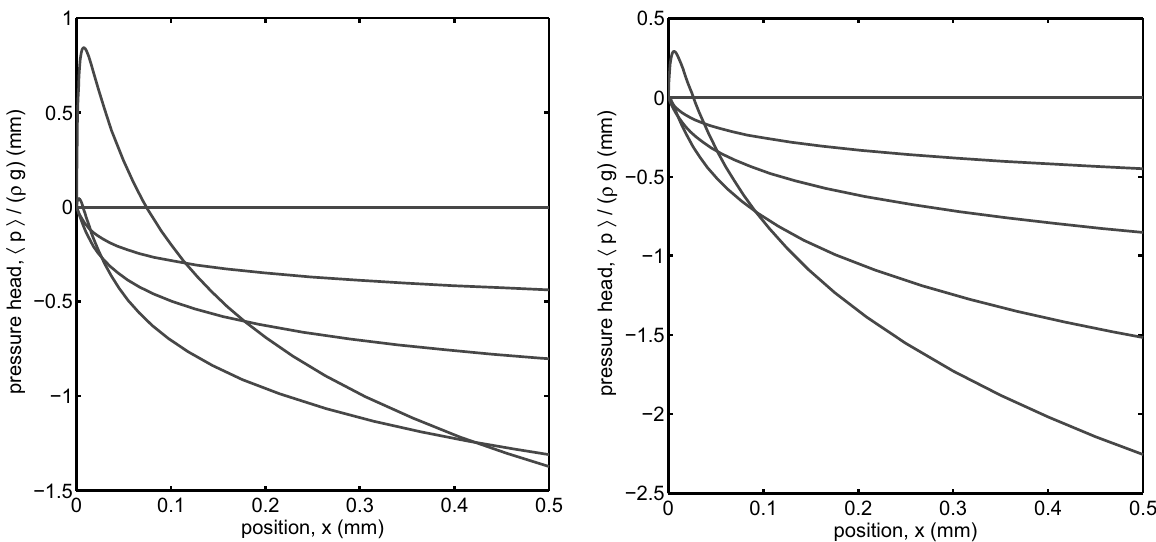
Fig. 3 – Bulk pressure head h p i /(ρ g ) (mm) as a function of position x (mm), decreasing monotonically at x = L with increasing particle volume fraction φ = φ ∗ ( 0 , 0 . 1 , 0 . 2 , 0 . 4 , 0 . 8 ) = ( 0 , 0 . 0534 , 0 . 1069 , 0 . 2137 , 0 . 4275 ) × 10 − 3 : constant charge density σ μ C cm − 2 (left panel); constant ζ -potential ζ / e = − 4 kT ≈ − 100 mV (right panel). The accompanying bulk electrolyte = 1 concentration gradient is practically constant. See text and Tables I–III for other microscale